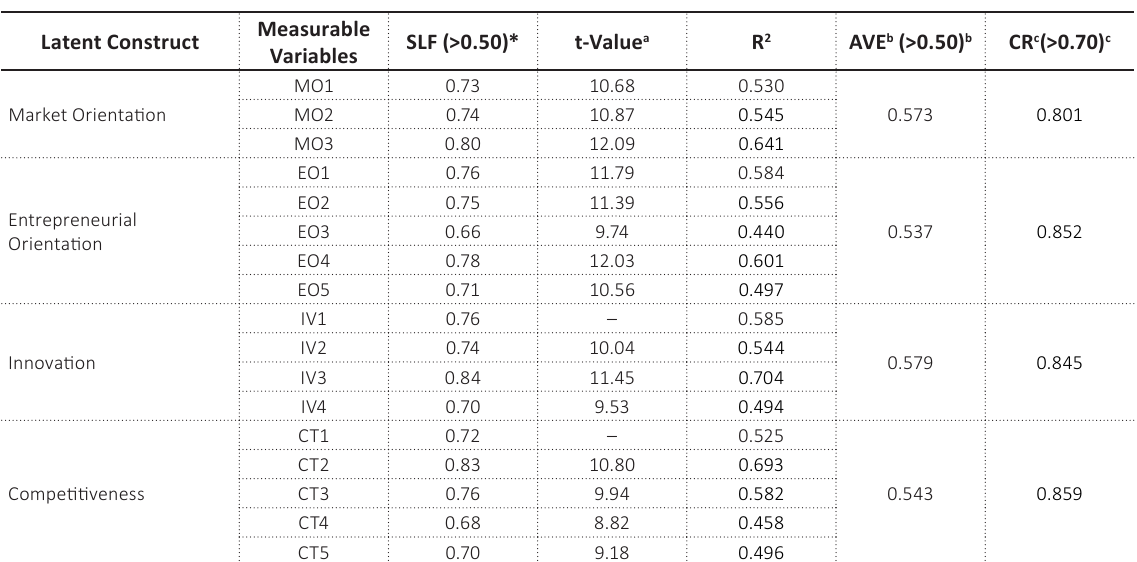
Table 3. Results of the measurement model